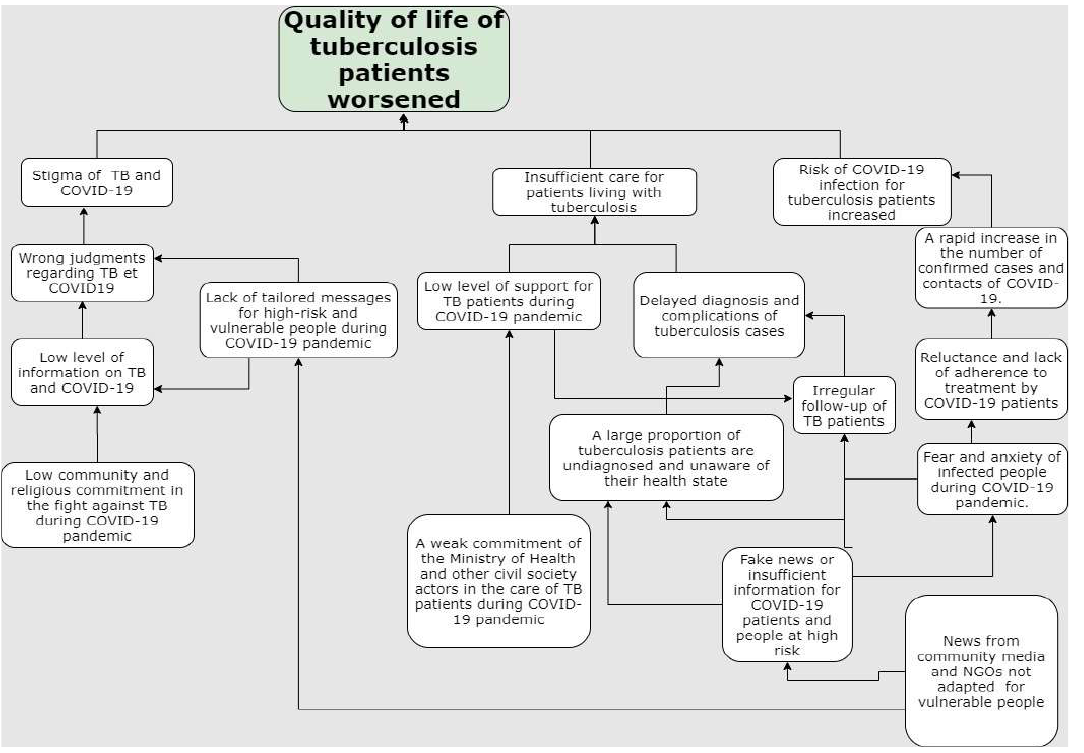
Figure 1. Hypothesized problem tree of HQoL of TB patients during the COVID-19 pandemic in Guinea.